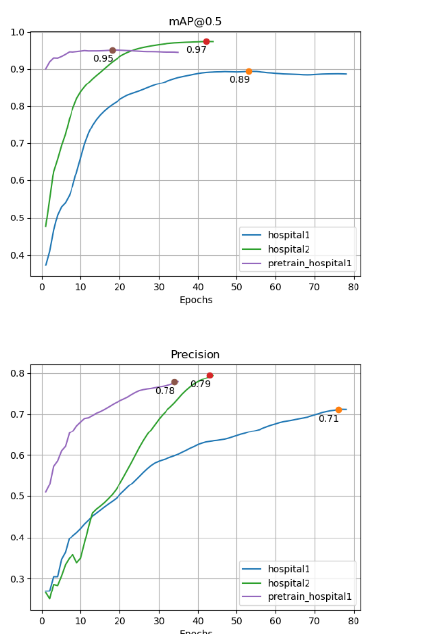
Figure 12. Images per class distribution. The classes are: 0 = person without any handicap; 1 = person using crutches; 2 = person in a wheelchair; 3 = person in a wheelchair that is pushed by another person; 4 = person using a walking frame. ( a ) Hospital1 ( b ) Hospital2.